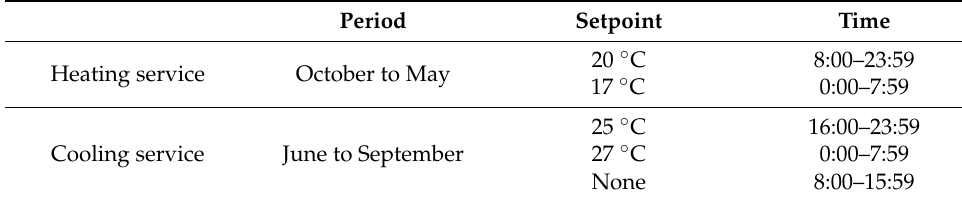
Table A2. Air-conditioning timetables and set